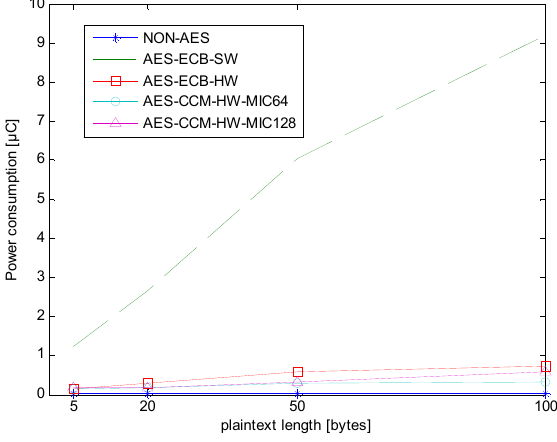
Figure 6. Encryption power consumption of different encryption types.